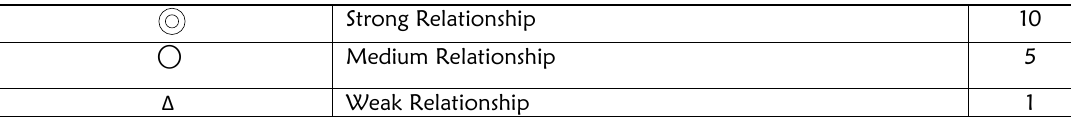
Table 3: Legend of symbols for House of